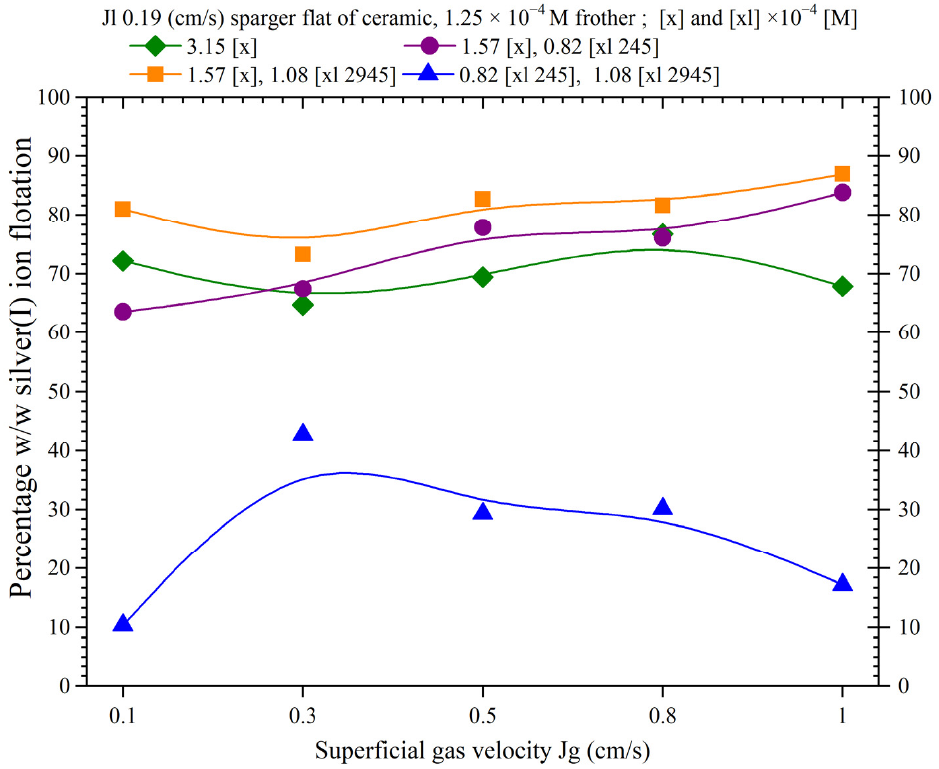
Figure 10. Percentage of w / w silver(I) recovery by ion flotation as function of superficial gas velocity, collector–promoter and promoter combinations Jl 0.19 cm/s, ceramic sparger fl at.